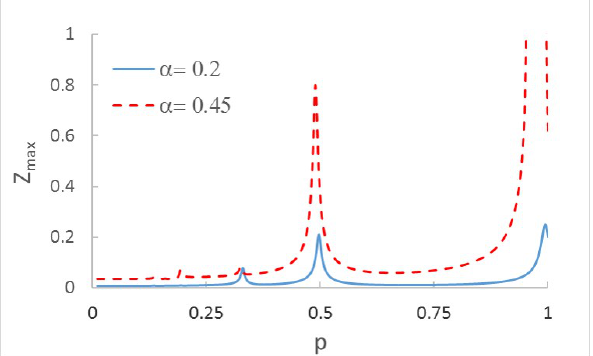
Figure 3. Displacement in the Z direction in mm for the speed rotation sweep and two crack depths: α = 0.2 and α =